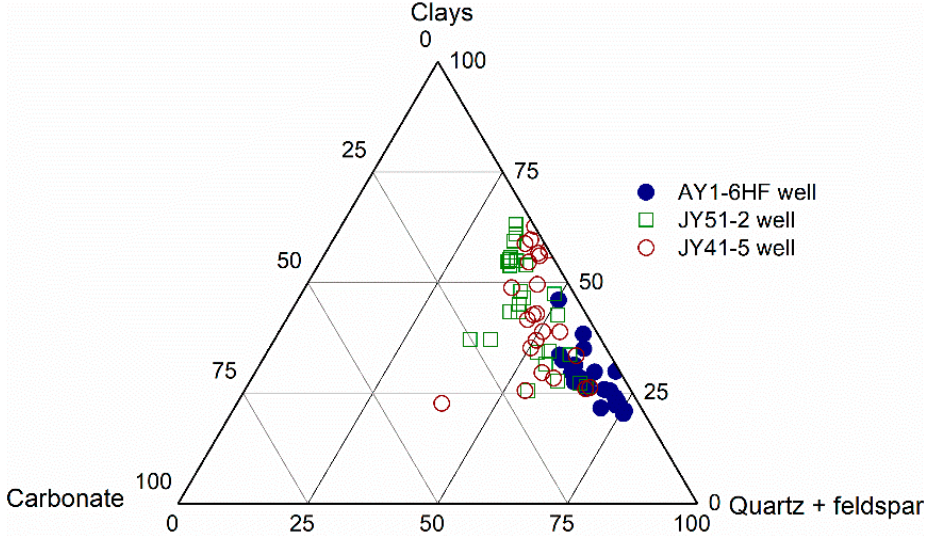
Figure 4. Mineralogical ternary plot of the Wufeng–Longmaxi shales from the Anchang Syncline and the Jiaoshiba Area (data from JY41-5 and JY51-2 wells are collected from [30,31]).